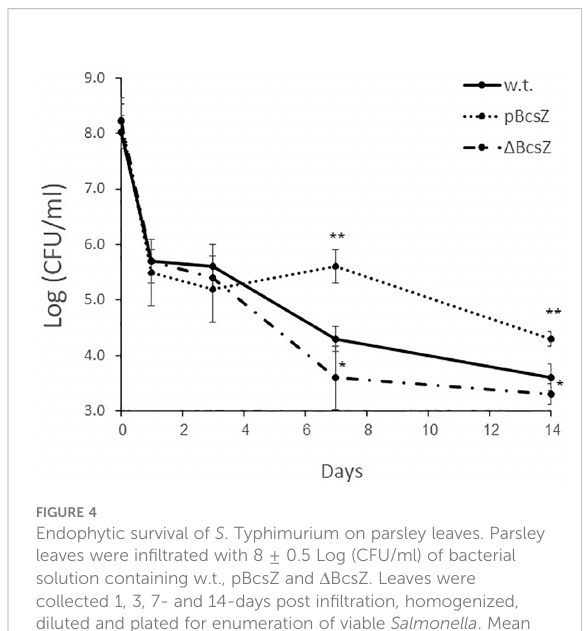
FIGURE 4 Endophytic survival of S . Typhimurium on parsley leaves. Parsley leaves were in fi ltrated with 8 ± 0.5 Log (CFU/ml) of bacterial solution containing w.t., pBcsZ and D BcsZ. Leaves were collected 1, 3, 7- and 14-days post in fi ltration, homogenized, diluted and plated for enumeration of viable Salmonella . Mean values of three experiments, each one was conducted in duplicates, are presented, and were statistically analyzed using Fisher ’ s protected least signi fi cant difference test (** P < 0.01, * P < 0.05). Error bars represent standard